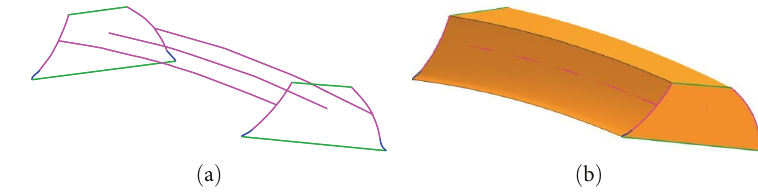
ð a Þ ð b Þ F IGURE 16: Single tooth formation process of the asymmetric logarithmic